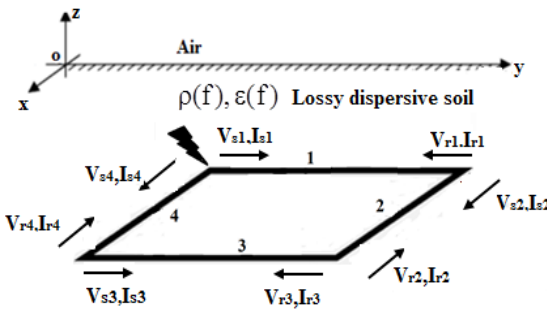
Figure 1: Schematic diagram of a grounding grid of size .